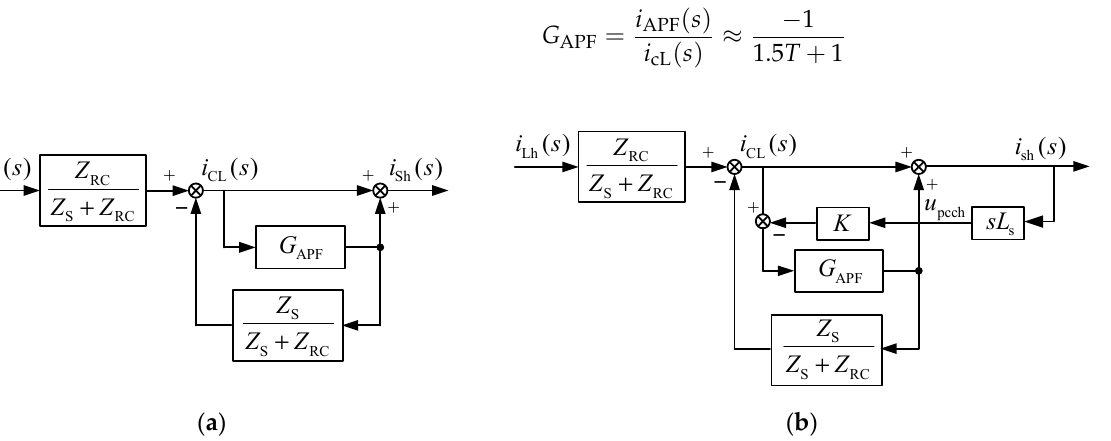
Figure 8. Control block diagrams of the system ( a ) without virtual damping; ( b ) with virtual